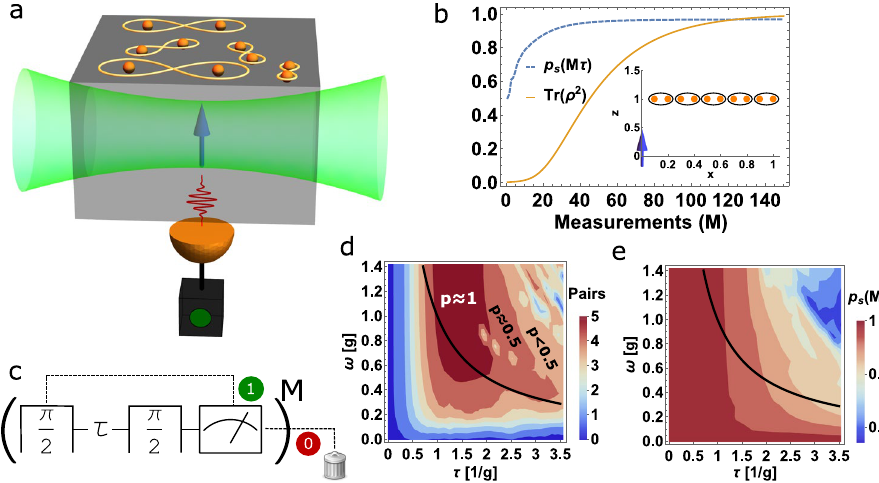
Figure 1. ( a ) Schematic illustration of the scheme, where the central spin (single NV center in diamond) shown as solid blue arrow, is dipolar coupled to nuclear spins (orange spheres) on the surface. The spin is initialized and read out optically. Successful state selective readouts lead to pairwise entanglement of the nuclear spins. ( b ) The purity and the success probability as a function of the number of measurements M is shown for a spin ensemble of 10 spins. The inset shows the linear chain of nuclear spins considered for this calculation. ( c ) Schematic of the pulse sequence and measurement on the NV electron spin. The ω − τ contour plots in units of (cid:31)(cid:30) 2 are illustrating ( d ) the total number of singlet pairs and ( e ) the final the effective coupling = ∑ g N g 1/ k k success probability P S ( M τ ). In ( d ) we also show the corresponding purity p of the spin bath. Moreover the line ω = 1/ τ is plotted in ( d and e ) to indicate a good choice of time and frequency for both pairing and success